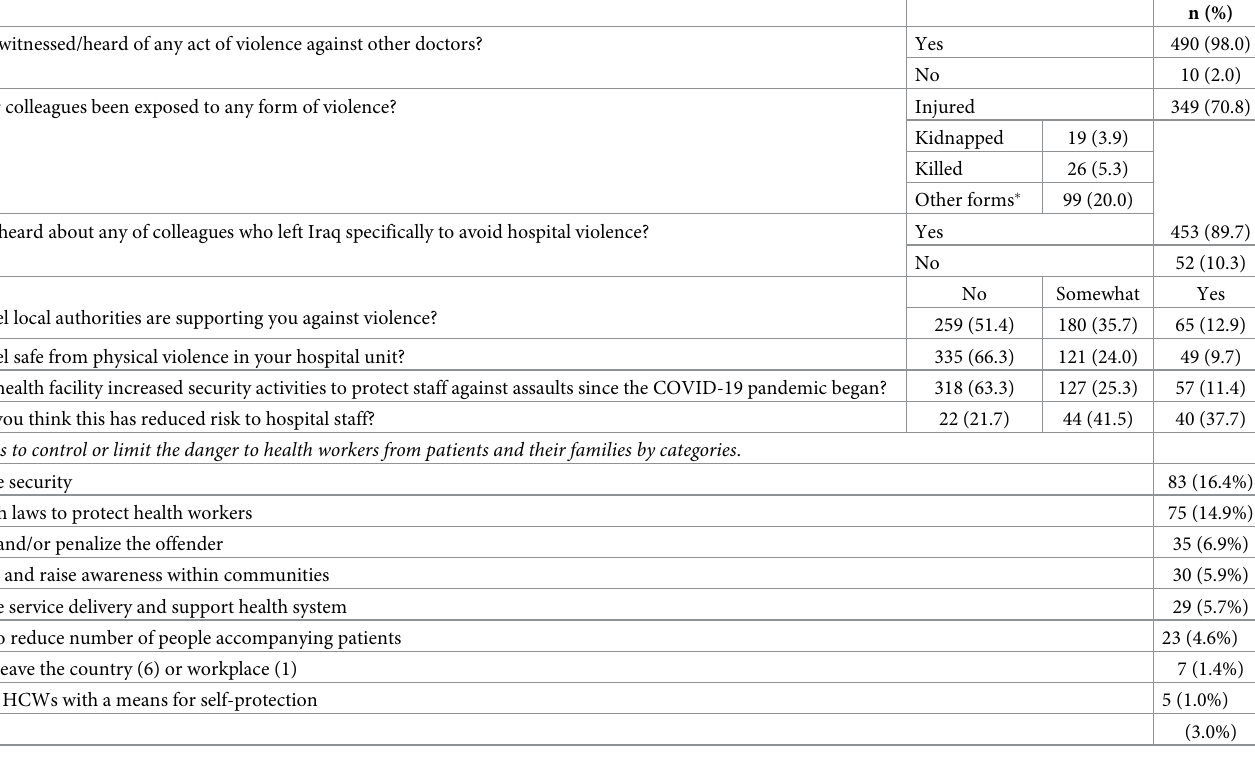
Table 4. Impact of violence on health services reported by 505